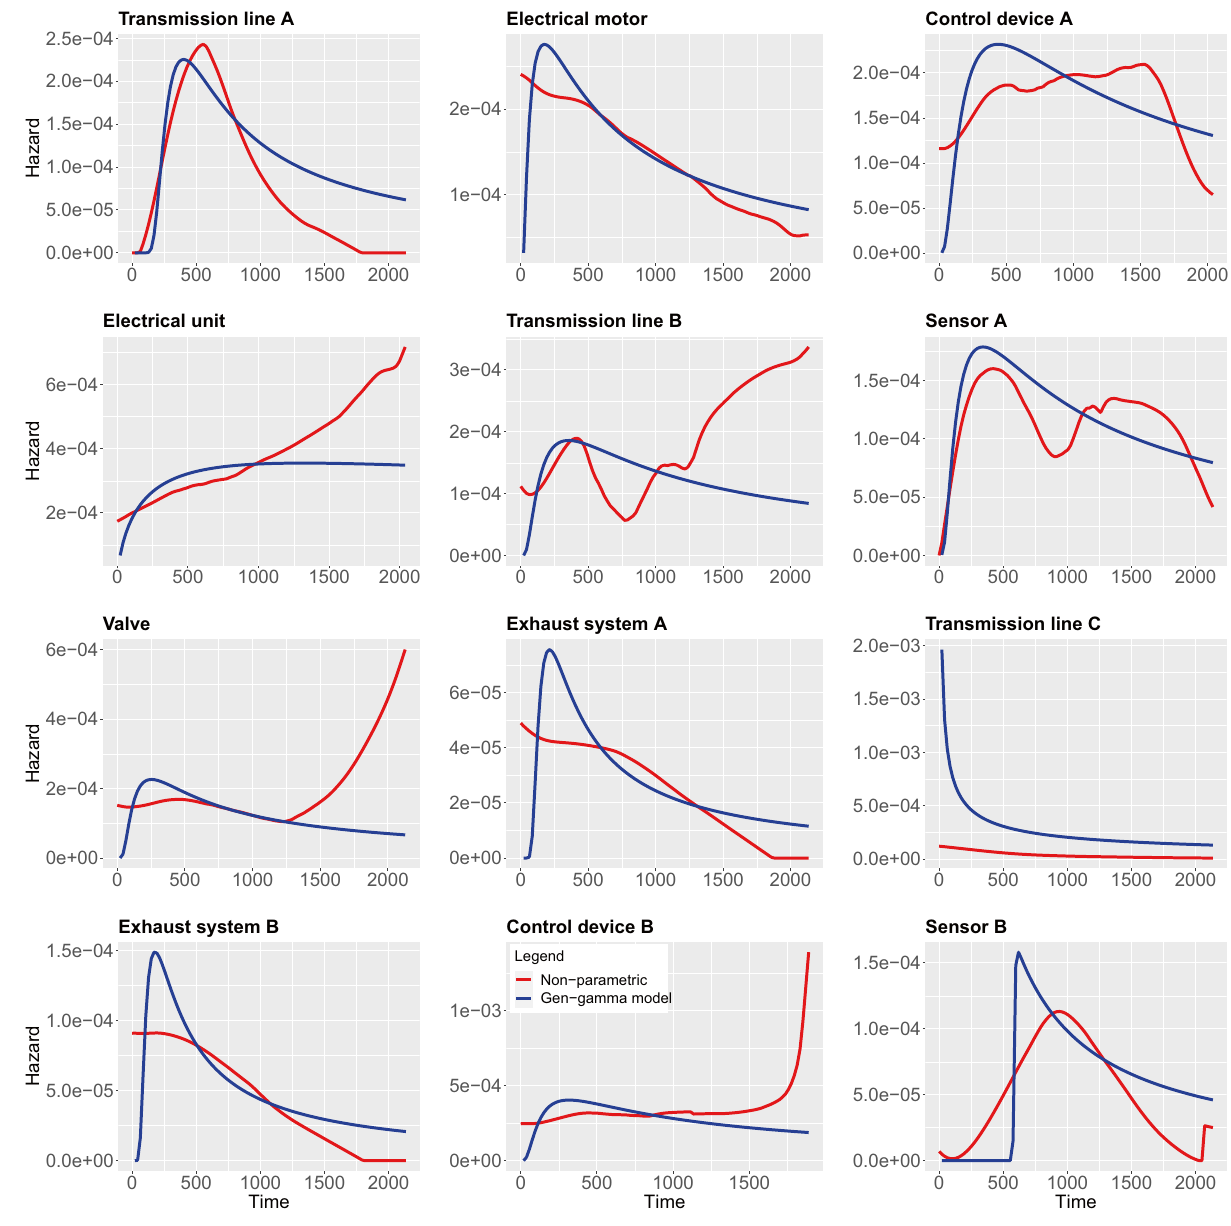
Figure 11. Generalized-gamma model hazard. Blue curve indicates Generalized-gamma model hazard and red curve represents non-parametric kernel-estimator